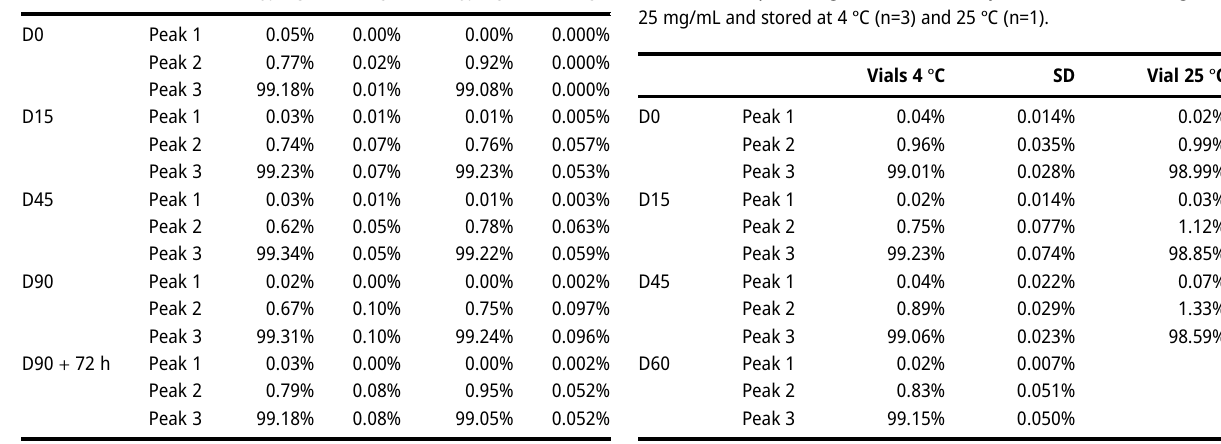
Forthevials,after  days,noadditionalpeaksappeared,irrespectiveofthe temperature and storage duration tested, demonstrating the absence of oligomer formation and of changes in the drug that would have led to